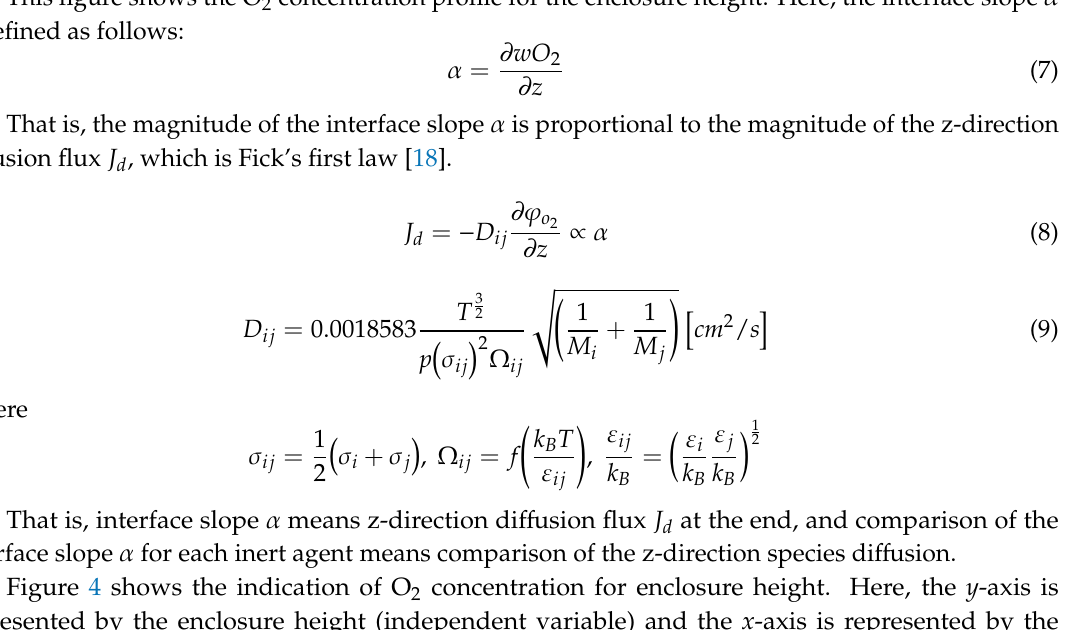
Figure 4. Schematic diagram for the O 2 concentration distribution profile for calculating interface slope α.